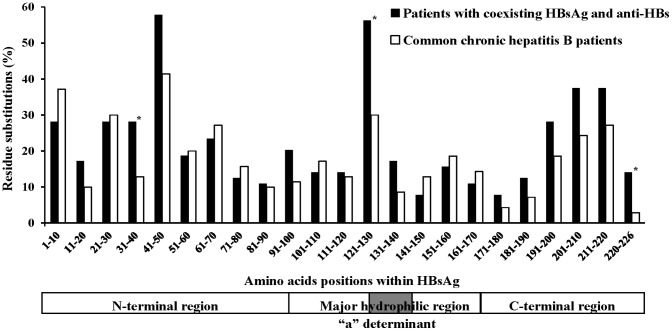
Amino acid mutation within HBsAg.Amino acid substitutions from chronic HBV-infected patients with or without anti-HBs positive in serum (analyzed at intervals of 10 amino acids) were identified through comparison the sequences with known wild-type virus from GenBank. Each bar represents the percentage of patients with mutated amino acid residues in each group at each interval of 10 amino acids per group. *Indicating the subregion harboring sequences mutations in patients with coexisting HBsAg and anti-HBs was significantly more than that in the control patients.